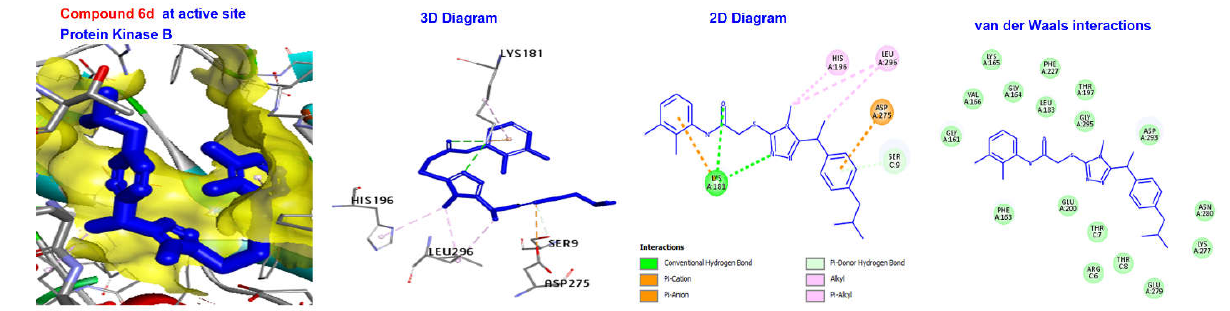
Figure 4. Binding pocket of docked ligand 6d in active site of Protein Kinase B.